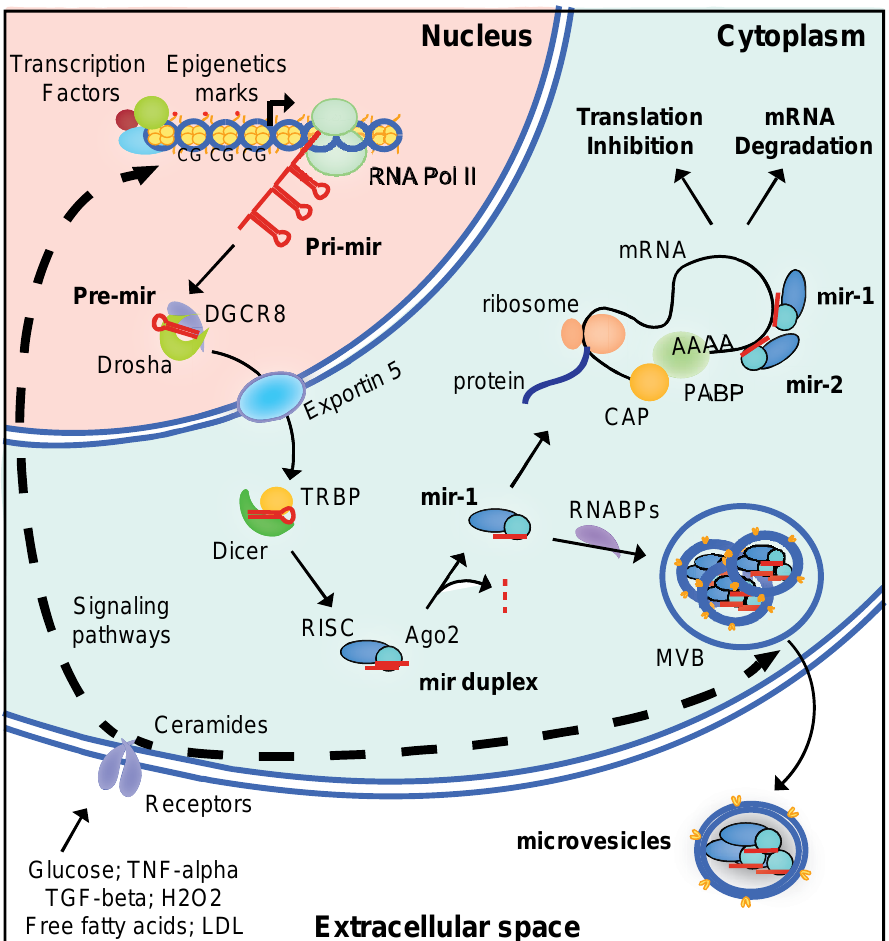
Figure 1. Canonical pathways of biosynthesis, mechanism of action and secretion by adipocytes of microRNAs. Following external stimulation, non-coding genes are transcribed by the RNA polymerase II (RNA pol II) to produce a pri-microRNA (pri-mir). These genes are under classical transcriptional regulation by transcription factors and epigenetics marks, such as DNA methylation at CpG sites (CG) and histone post-translational modifications. The pri-mir is processed by Drosha and DGCR8 to produce the pre-microRNA (pre-mir), which is transferred to the cytoplasm for further processing by Dicer and TRBP. The cleaved mir duplex is carried by Ago2 into the RISC complex, and the active mir strand of 21 – 25 nucleotides is driven to the 3 ′ UTR of the targeted mRNA(s). Depending on the presence of a mismatch between the seed sequence of the mir and the mir-binding site of the mRNA, mRNA translation is inhibited or the mRNA is degraded. In parallel, mir can be transferred by RNA binding proteins (RNABPs) into multivesicular bodies (MVB) for exosome secretion (CD63 + ). These exosomes can then target cells at long distance.